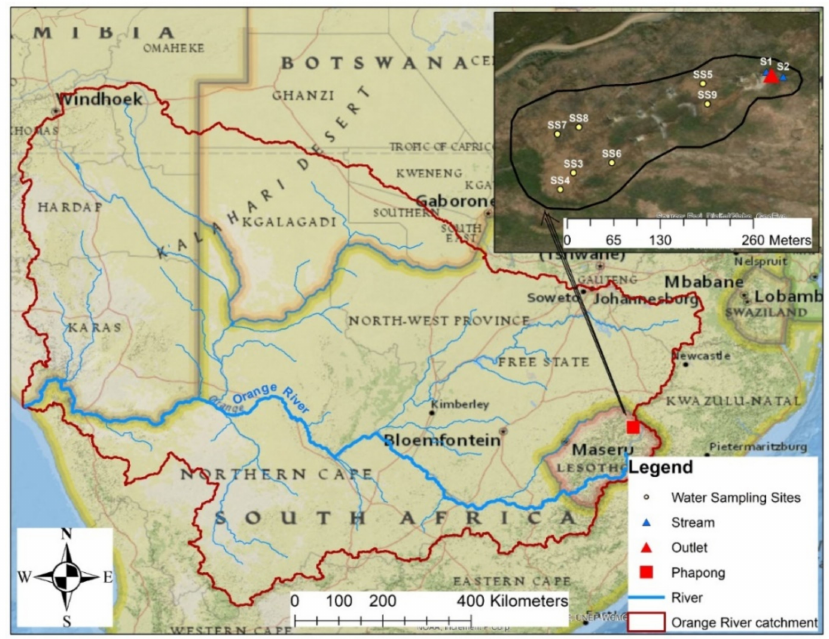
Figure 1. Location of the Khubelu wetland within the Phapong sub-catchment, showing wetland sampling sites and stream sampling